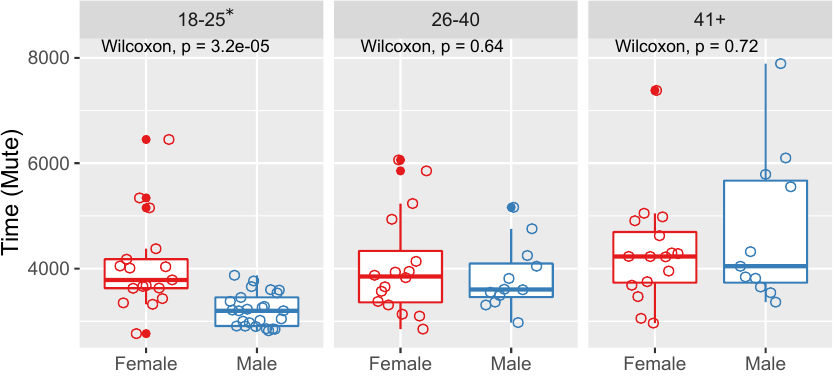
Figure 14. Boxplots comparing age groups of males and females regarding errors in “Mute” condition. Significant differences are marked with